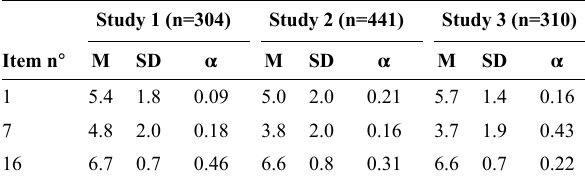
Table 3 - Cronbach's Alpha of the introjected regulation dimension when each item is excluded. Study 1 (n=304)